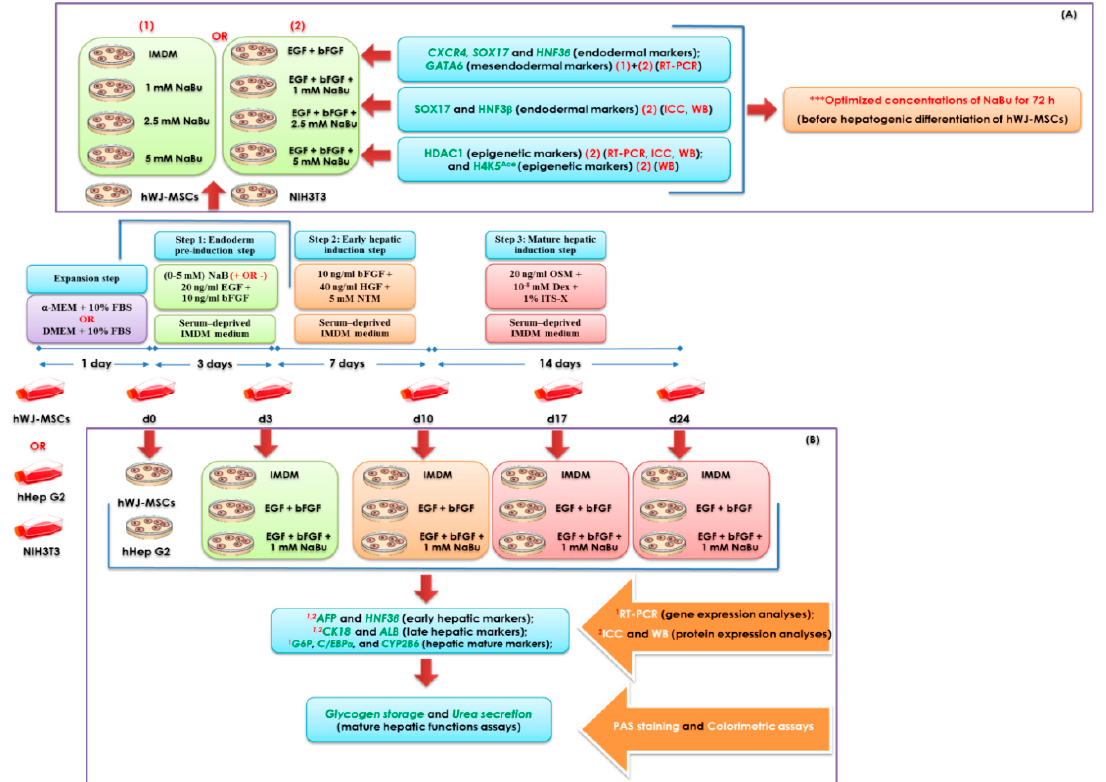
Figure 8. A schematic diagram of the human Wharton’s jelly–derived mesenchymal stem cells (hWJ–MSCs) hepatogenic differentiation protocol. ( A ) A schematic representation of the optimization of NaBu used for hepatogenic differentiation of hWJ–MSCs by assessing epigenetic statuses and endodermal differentiation of hWJ–MSCs for 3 days. ( B ) The representation of hWJ–MSCs differentiation toward hepatic lineage by using modified 3–step differentiation protocol and their characterizations.